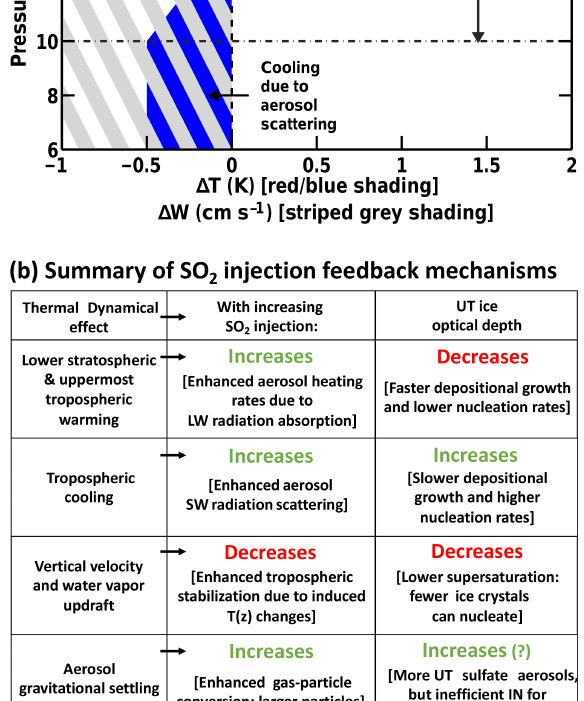
Figure 3. (a) Schematic profile changes of upper troposphere–lower stratosphere temperature (K) and UT vertical velocity (cms − 1 ) in the tropics, due to a geoengineering injection of 5TgSO 2 yr − 1 . The perturbation scheme is based on the findings of Kuebbeler et al. (2012) and Pitari et al. (2016c, 2014). The dash-dotted black lines indicate the region of ice particle formation (up to the mean tropopause). The sensitivity of each thermal-dynamical effect to the SO 2 injection is highlighted in (b) , along with the physical mecha- nisms driving the perturbation and the net effect on UT ice optical